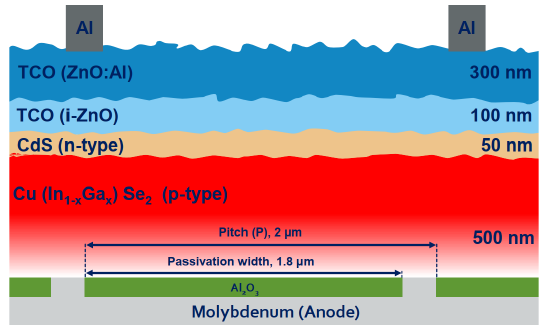
Figure 1. Structure of 2D passivated u-CIGS solar cell model.